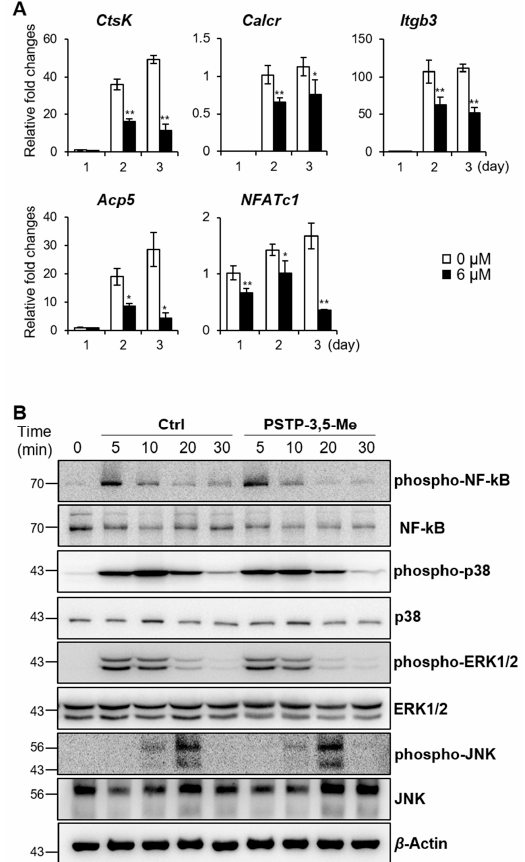
Figure 3. CtsK and NFATc1 expression levels were decreased during osteoclastogenesis by PSTP-3,5-Me treatment. ( A ) mRNA expression levels of osteoclast-specific markers were determined by RT- PCR in 0 or 6 µM PSTP-3,5-Me-treated cells. * p < 0.05, and ** p < 0.01 indicate the statistically significant difference between non-PSTP-3,5-Me-treated groups (0 µM) and PSTP-3,5-Me-treated groups (6 µM) on each day. Mean ± standard error. ( B ) Western blotting was performed to determine phosphorylation of NF-kB, p-38, ERK1/2, and JNK. Cells were pre-treated with 6 µM PSTP-3,5-Me or vehicle (Ctrl) for 2 h, and then treated with RANKL for the indicated times. β -Actin expression level was used as a loading